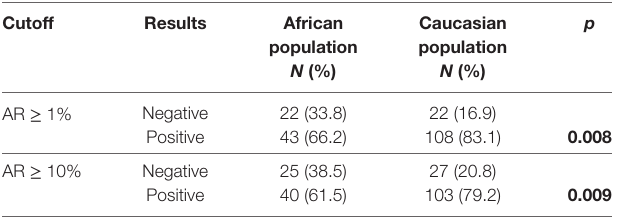
TaBle 4 | Androgen receptor (AR) in Caucasian and African populations.